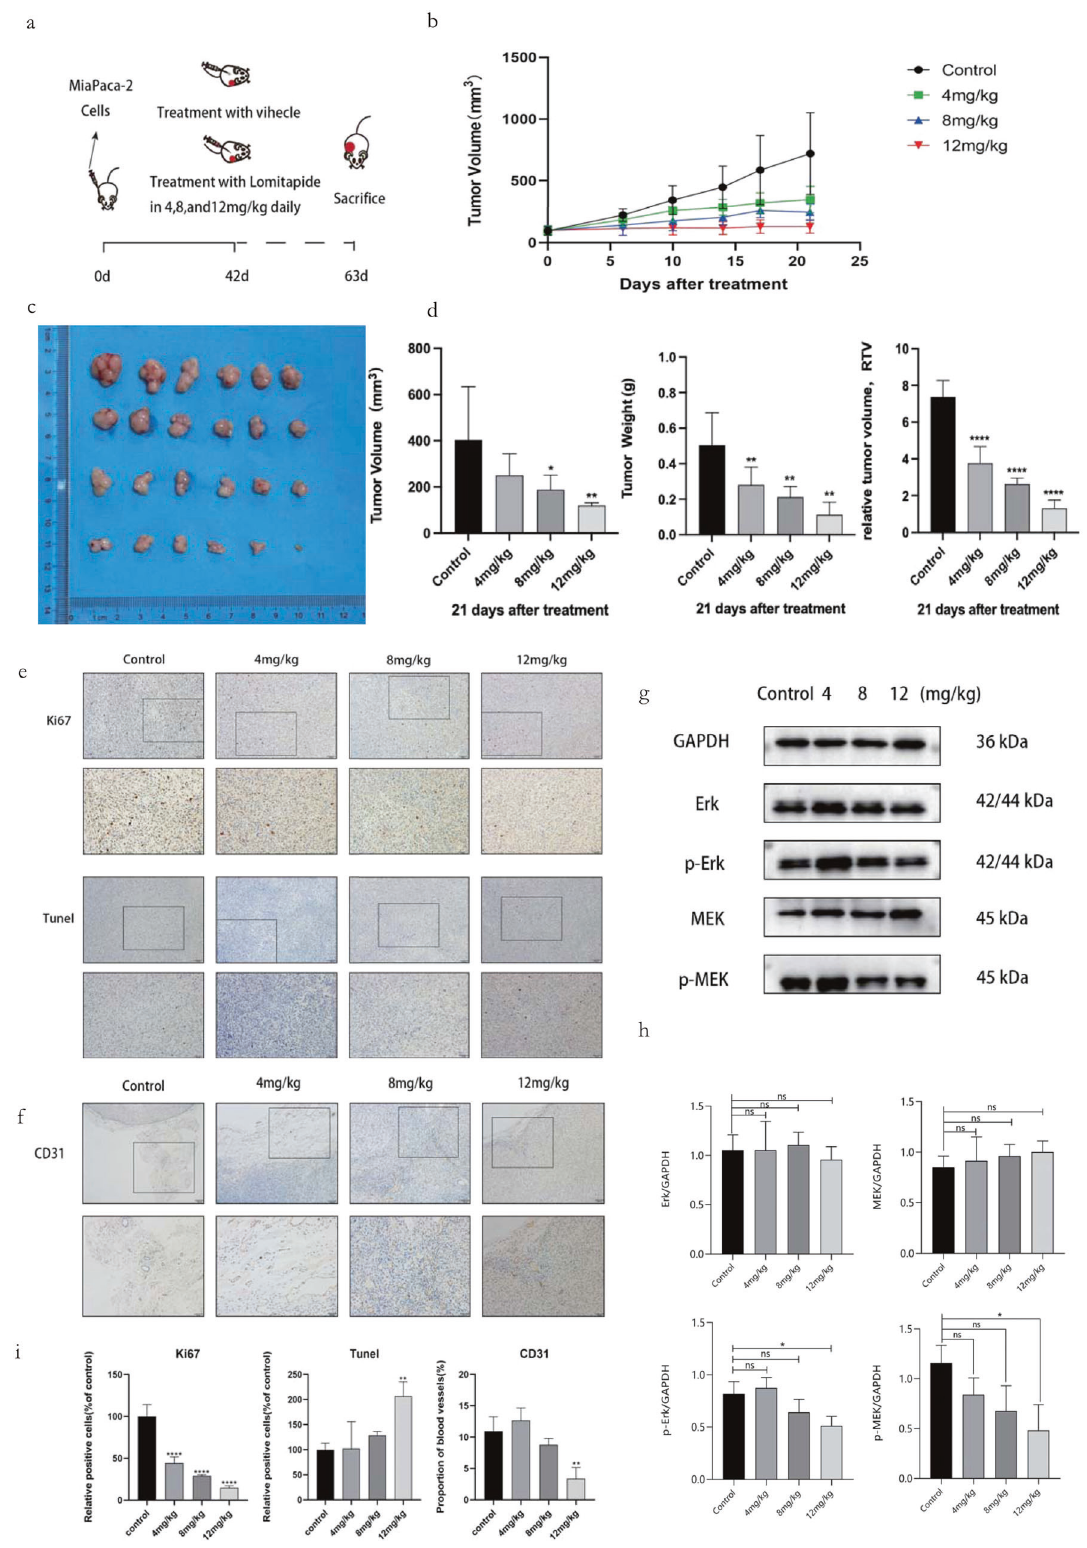
Single-cell transcriptome sequencing and analysis See Online methods. In Brief, two tumor samples of pancreatic cancer patients were collected for single-cell transcriptome sequencing. In comparison, two normal pancreatic tissue single-cell transcriptome data